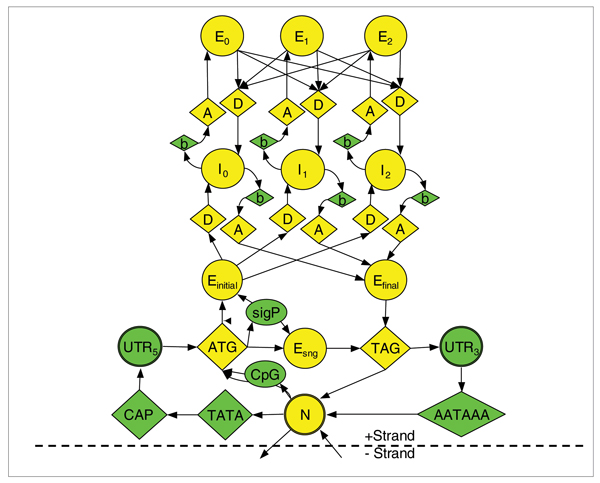
State-transition diagram of the GHMM-based gene finder GeneZilla. Green states were differentially included for the feature-state experiments. Reverse-strand states have been omitted for brevity. A, acceptor site; AATAAA, polyadenylation signal (including ATTAAA); ATG, start codon; b, branch point; CAP, cap site; CpG, CpG island; D, donor site; E, exon; I, intron; N, intergenic; sigP, signal peptide; TATA, TATA box; TAG, stop codon (including TAA and TGA); UTR, untranslated region.